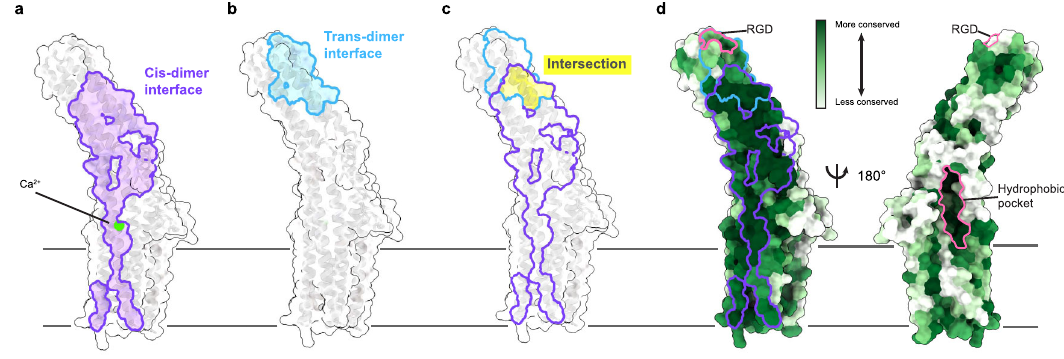
Fig. 4 Conservation and partial overlap of the TTYH2 cis - and trans -dimerization interfaces. a “ Open book ” view of the molecular surface of one TTYH2 protomer. The cis -dimerization interface is outlined and colored purple. The position of the bound Ca 2 + is shown. b Open book view of the molecular surface of one protomer from the TTYH2 trans -dimer. The trans -dimerization interface is outlined and colored blue. c Overlay of cis -dimerization (purple outline) and trans -dimerization (blue outline) interfaces with intersection highlighted in yellow. d TTYH2 surface colored according to conservation among chordate TTYH1-3 sequences. cis -dimer and trans -dimer interfaces are outlined as in a – c . The extracellular hydrophobic pocket and RGD motif are outlined